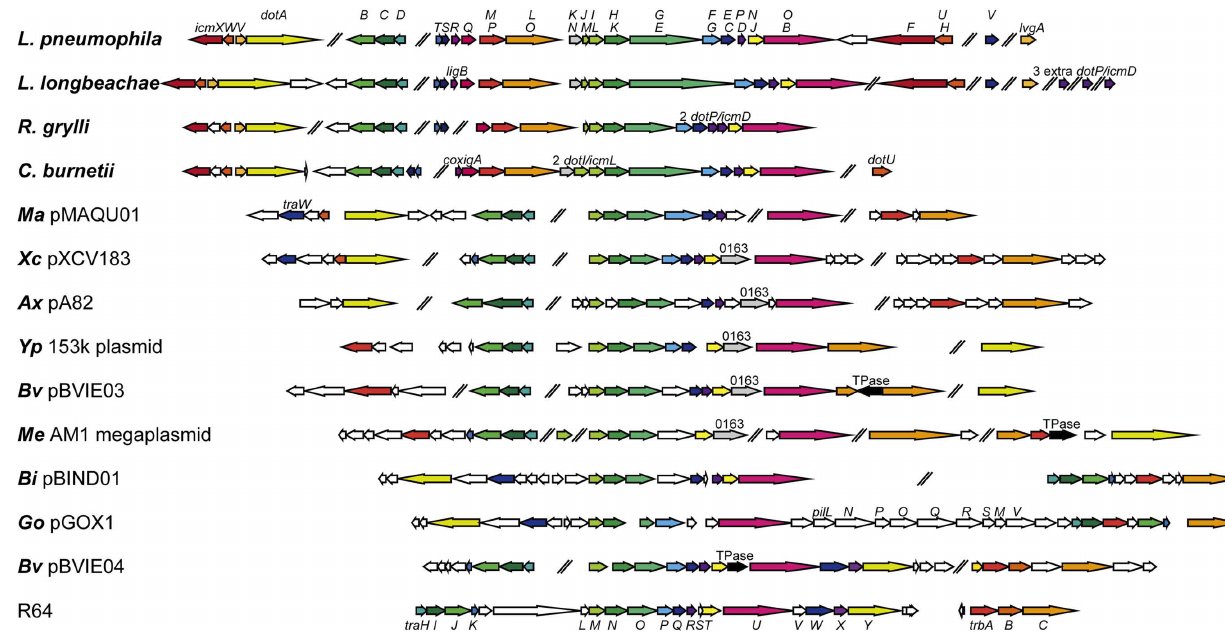
FIGURE 1 | Genetic organizations of selectedT4BSSs. Genetic organizations ofT4BSSs from the following bacteria or plasmids are illustrated. Legionella pneumophila strain Philadelphia 1 (GenBank accession no. NC_002942); Legionella longbeachae NSW150 (NC_013861); Rickettsiella grylli (NZ_AAQJ02000001); Coxiella burnetii RSA 493 (NC_002971); Marinobacter aquaeolei VT8 pMAQU01 (NC_008738); Xanthomonas campestris pv. vesicatoria str. 85-10 pXCV183 (NC_007507); Achromobacter xylosoxidans A8